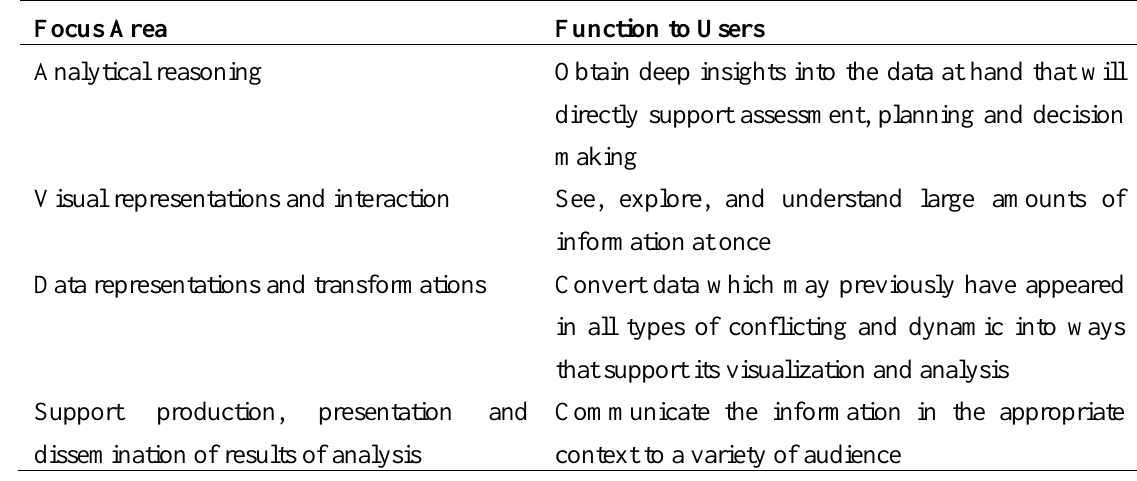
Table 2. Visual Analytics Focus Area Techniques a